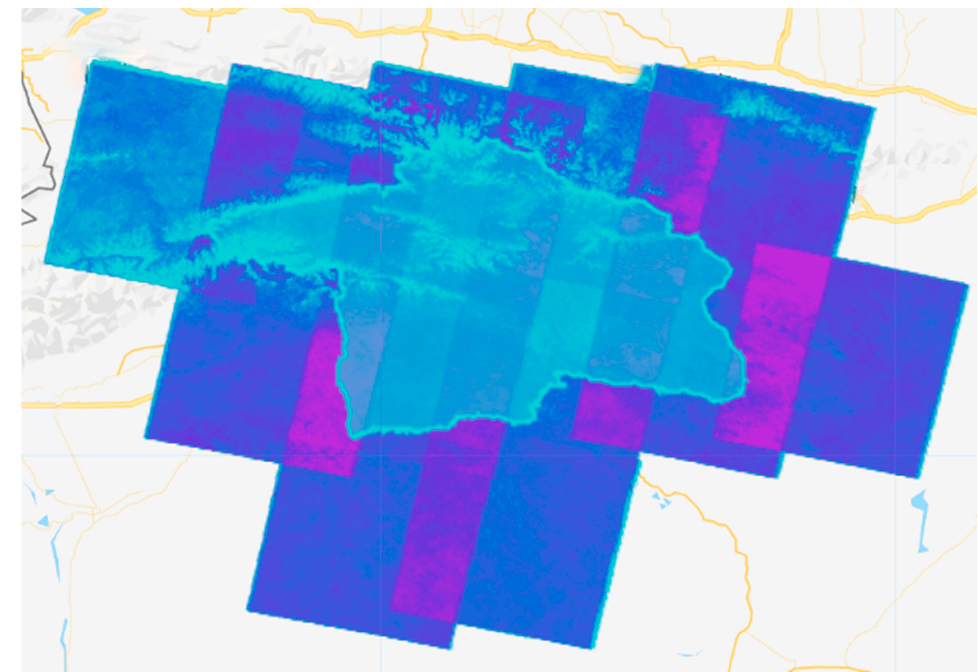
Figure 2. Image availability analysis in the study